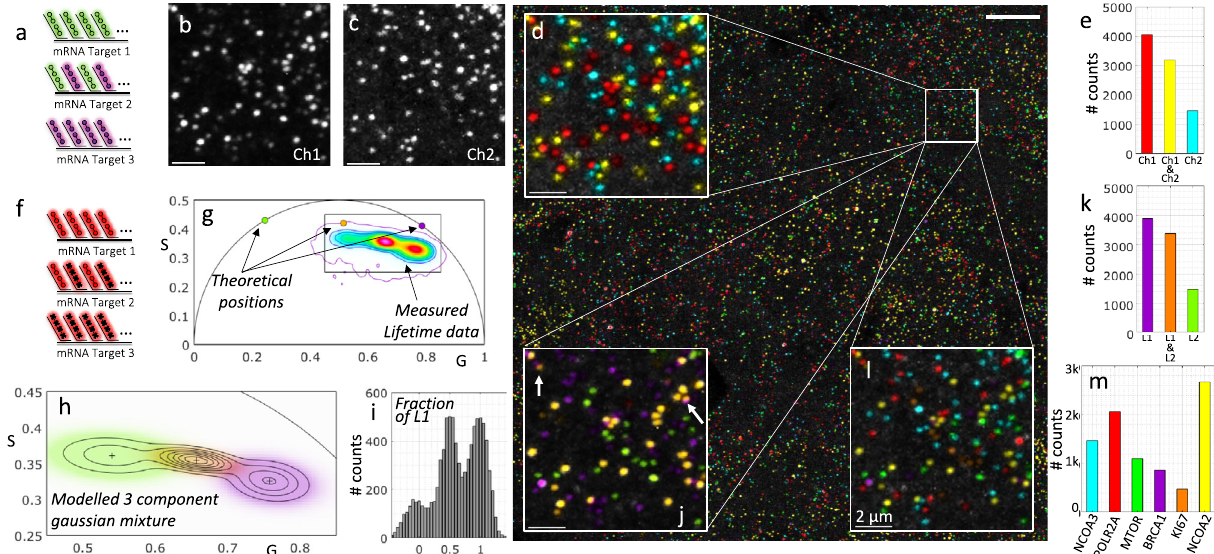
Fig. 3 Working example of combinatorial labelling of three mRNA targets with two probes. a Transcripts of three different target genes are tagged using two probes with different spectra. Targets 1 and 3 are tagged each with one probe, Target 2 is tagged with both simultaneously. b , c The fl uorescence is collected in the two expected spectral channels for the known emission of the two probes (representative small regions of a whole 3D fi eld of view). d The maximum projection of the two channels is shown and pseudo-colored depending on the presence in the respective channels (as an inset within the whole fi eld of view. e The actual counts of each target within the whole fi eld of view. f As a parallel example, transcripts of three different target genes are tagged using two probes with different lifetime. Targets 1 and 3 are tagged each with one probe, Target 2 is tagged with both simultaneously. g The phasor plot presents three populations, corresponding to the pixels with the three combinations; the two components by themselves plus the linear combination falling in the middle. h ) Machine learning clustering technique is used to identify the groups (Gaussian mixture model). i ) The multicomponent method is used to extract the fraction of one of the components in each detected puncta. j The same inset is shown with the pseudocoloring now depending on the lifetime clustering. k The counts for each lifetime cluster in the whole fi eld of view. l The combination of the information in both the spectral and the lifetime dimension yields a fi nal 6-plex. m The overall counts for the 6-plex detection of transcripts including POLR2A (Alexa647 & ATTO565), MTOR (ATTO647 & ATTO565), KI67 (Alexa647 & ATTO647), BRCA1 (Alexa647), NCOA2 (ATTO647), NCOA3 (ATTO565) with the appropriate expressed genes that correspond to each combination. Experiments were conducted with cultures of mNeon green cells. Scale bar 10 µ m in large image and 2 µ m in insets. Source data are provided as a Source Data fi